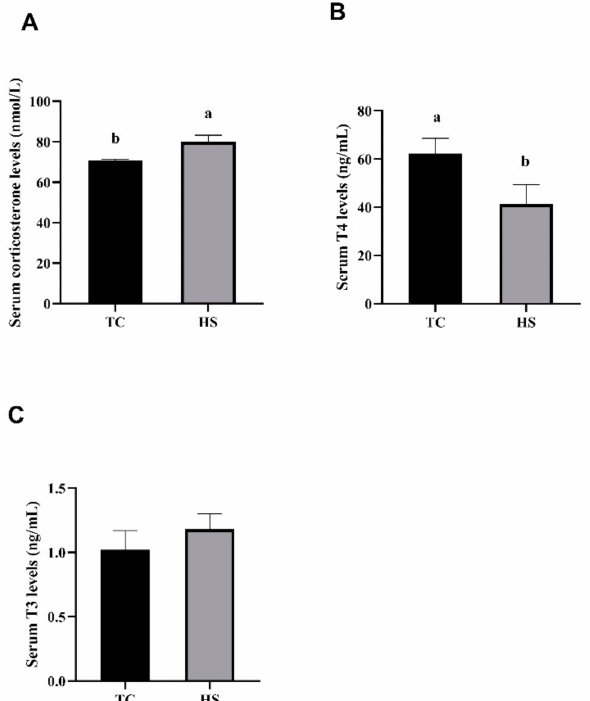
Figure 3. Effects of heat stress on the serum corticosterone ( A ), thyroxine (T4) ( B ) and 3,5,3 (cid:48) - triiodothyronine (T3) ( C ) levels in broilers. TC, thermoneutral control group; HS, heat stress group. Each bar presents the means ± SD ( n = 6). a,b Values with different superscripts differ significantly at p < 0.05.